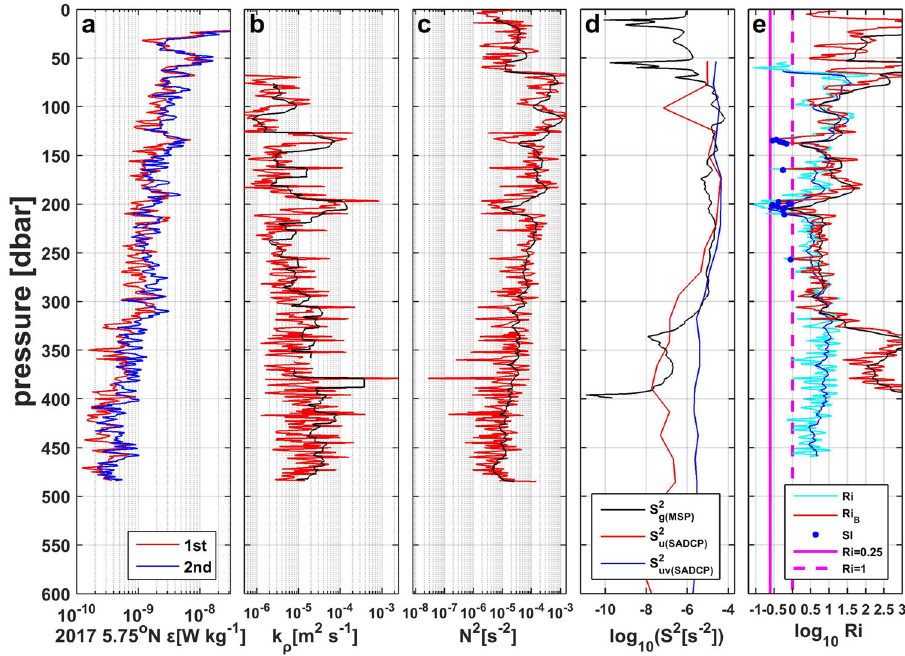
Fig. 4 Vertical pro fi le of direct microstructure measurements at station (5.75°N, 130°E) during the 2017 cruise. a Turbulent kinetic energy dissipation rate ε (W kg − 1 ), b diapycnal diffusivity ( κ ρ ), c squared buoyancy frequency ( N 2 ), d vertical shear squared calculated from shipboard ADCP measured zonal currents ( S 2 ), zonal and meridional currents S 2 , and from geostrophic current based on MSP observations ( S 2 ), and e gradient Richardson u ð SADCP Þ uv ð SADCP Þ g ð MSP Þ number, Ri, based on shipboard ADCP measurements, and balanced Richardson number, Ri B , as a function of depth with blue dots indicating those Ri B values meeting the criterion for the SI. Red and cyan curves in a – c and e represent data with a 1 m interval, and black and blue curves are 10 m average.